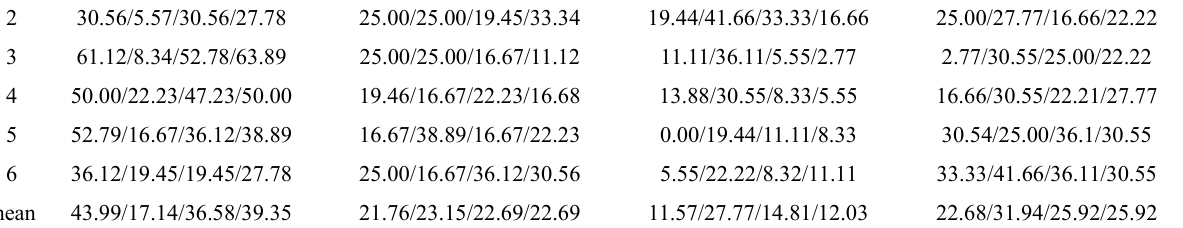
Table 2. Category percentage table of prediction residuals in ionospheric active period